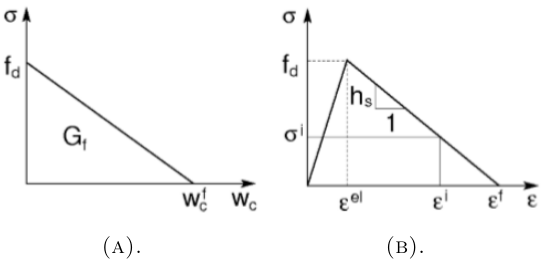
Figure 5. (A) Stress-crack opening displacement diagram with linear softening law, (B) stress-strain diagram with